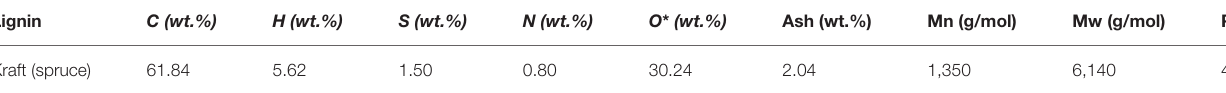
TABLE 1 | Physicochemical characteristics of kraft lignin (dry basis). Lignin